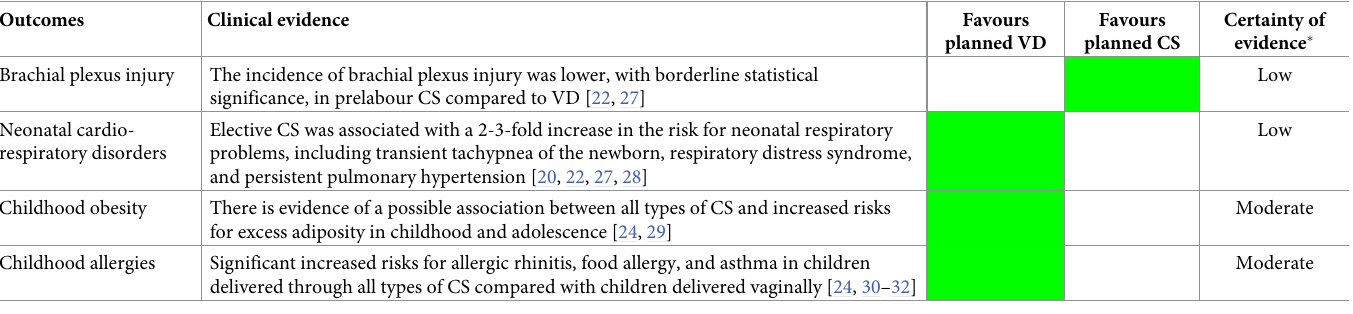
Table 4. Summary of infant outcomes and certainty of